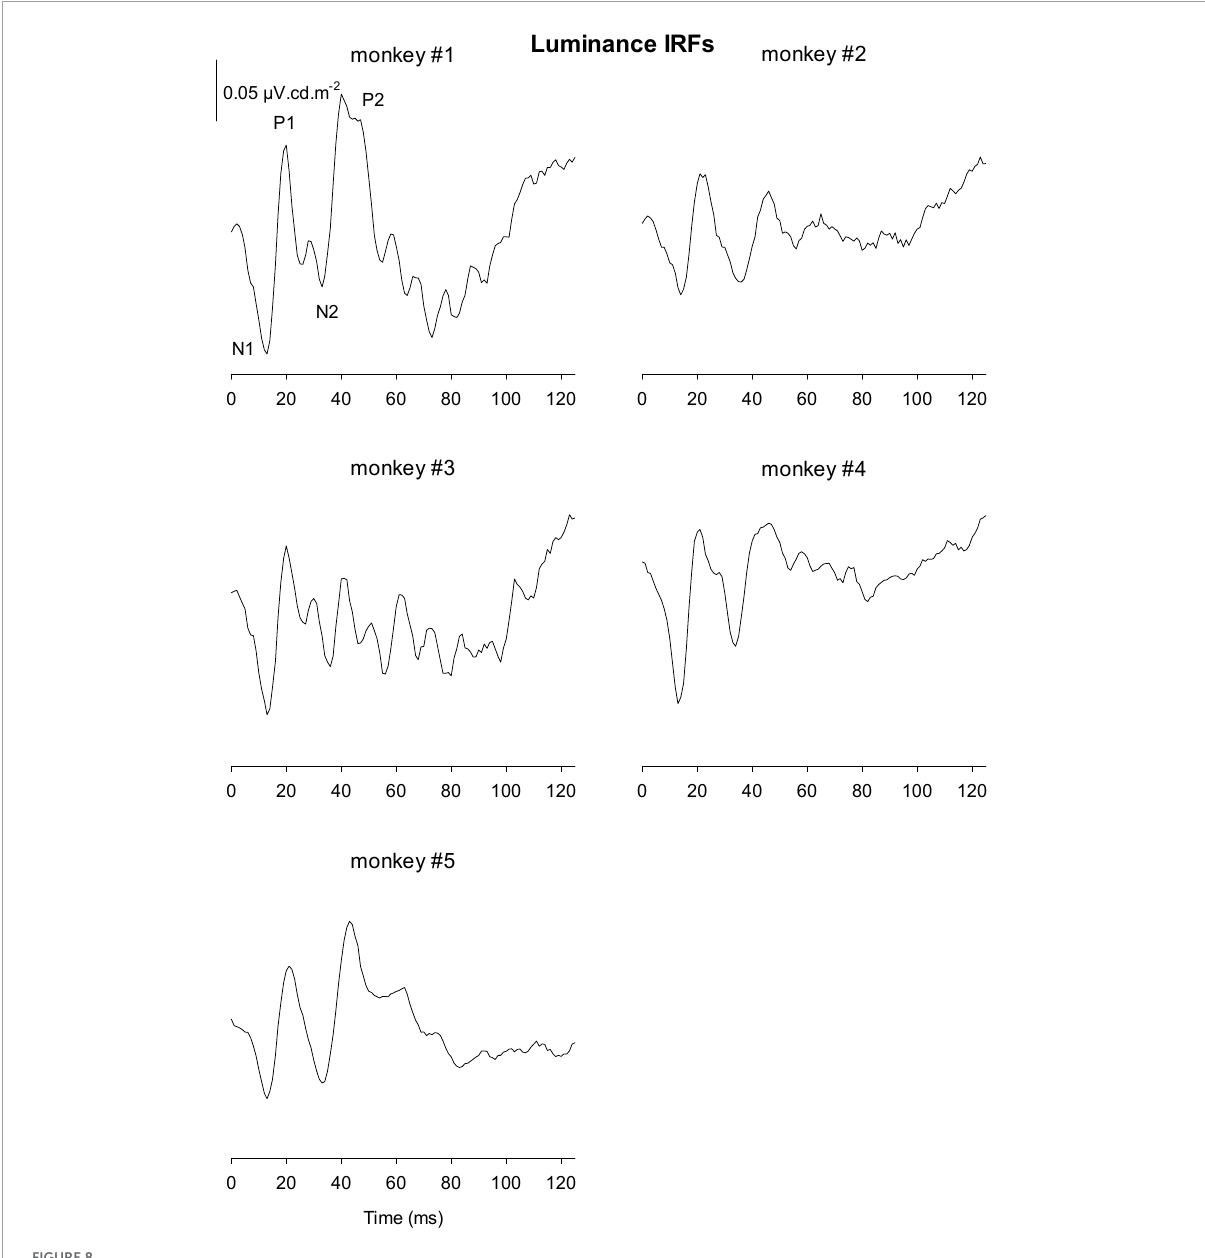
FIGURE8 Derived impulse response functions (IRFs) from wnERGs to luminance TWN stimuli for five monkeys. In the IRF of monkey #1, the four components are